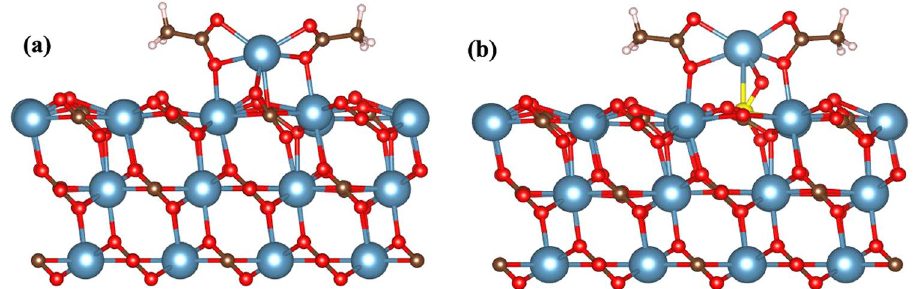
Figure 4. The atomic structures of Ca acetate on pure calcite ( a ) and modified calcite.SO 4 surfaces ( b ).